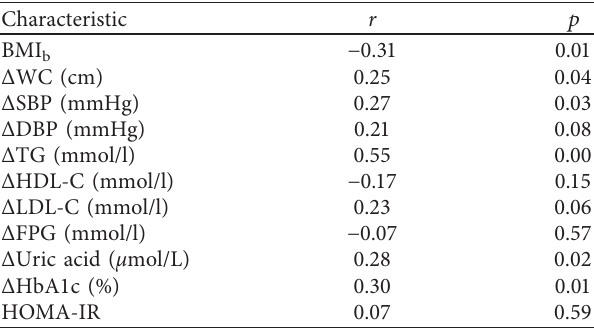
Table 2: Partial correlation of the change of BMI and the change of metabolic variables in 5